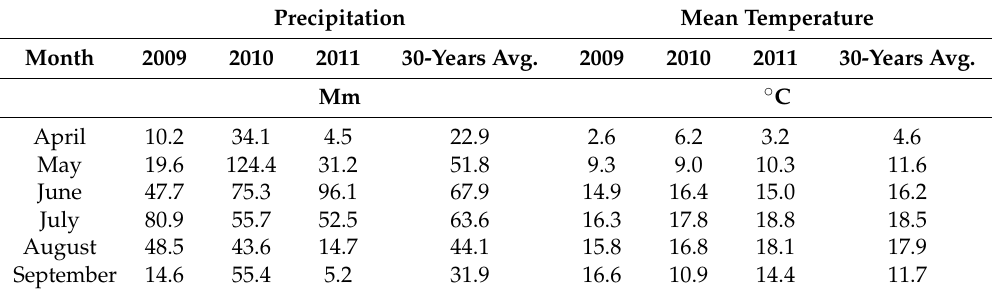
Table 2. Monthly total precipitation and mean air temperatures at the experimental site for the entire growing season for the three growing seasons